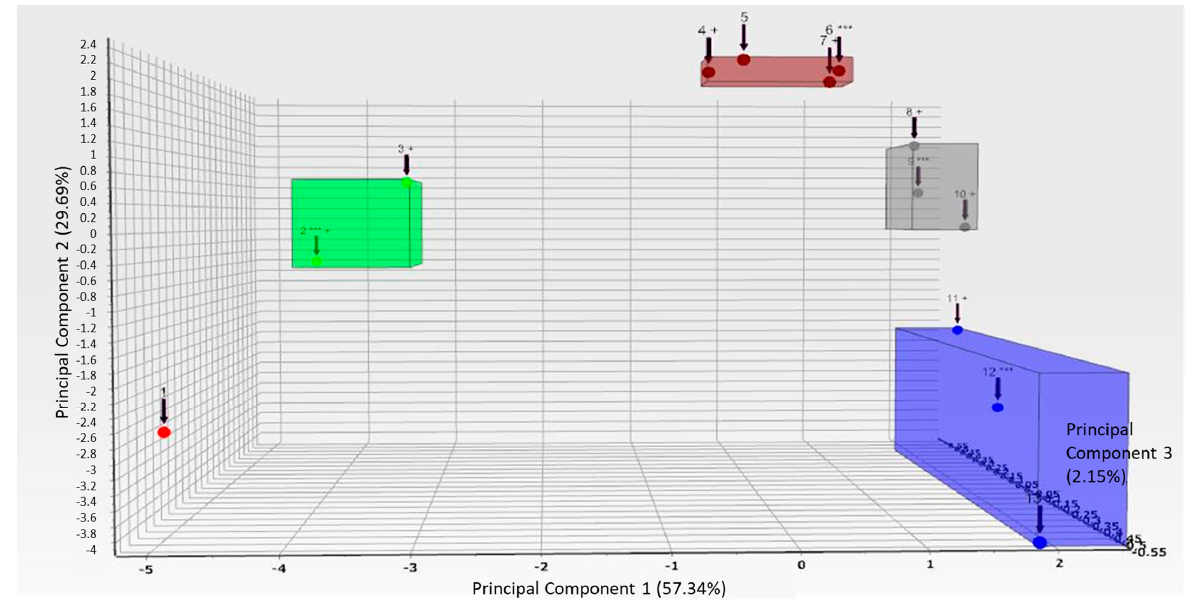
Figure 26. Clusters derived from different zinnwaldite–quartz mixtures. *** most representative sample of cluster, + are the most different ones in the clusters. The XRD patterns used for PLSR calculation and the different XRDs in the clusters are given in Figure 27.